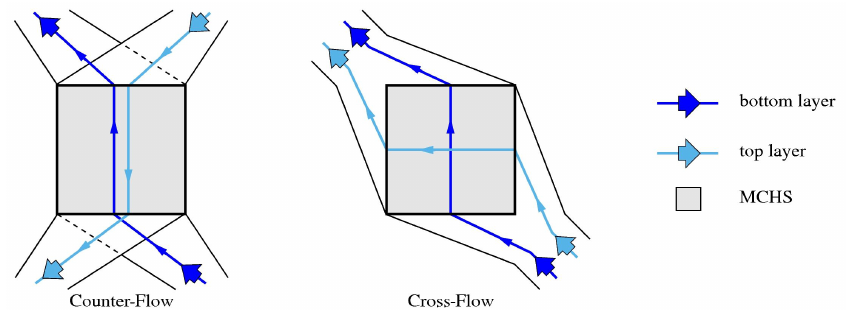
Figure 2. Schemes illustrating possible header layouts for counter-flow and cross-flow